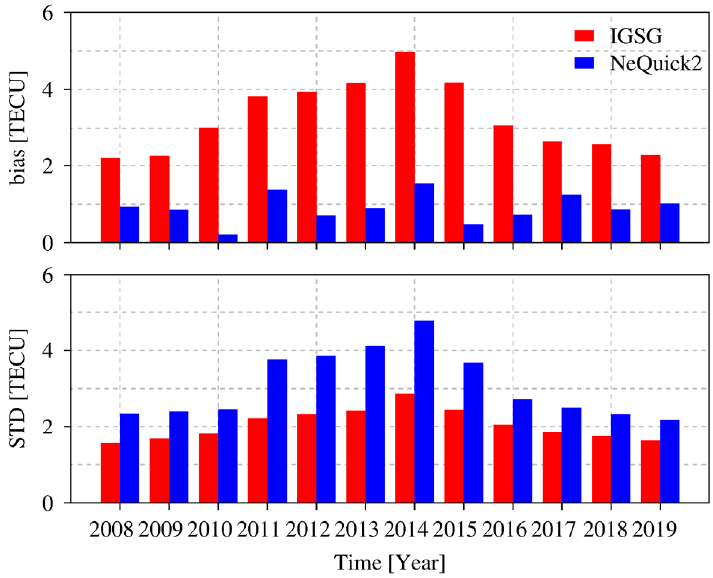
Figure 10. Statistical results of IGSG and NeQuick2 with respect to Jason2 VTEC for each year.